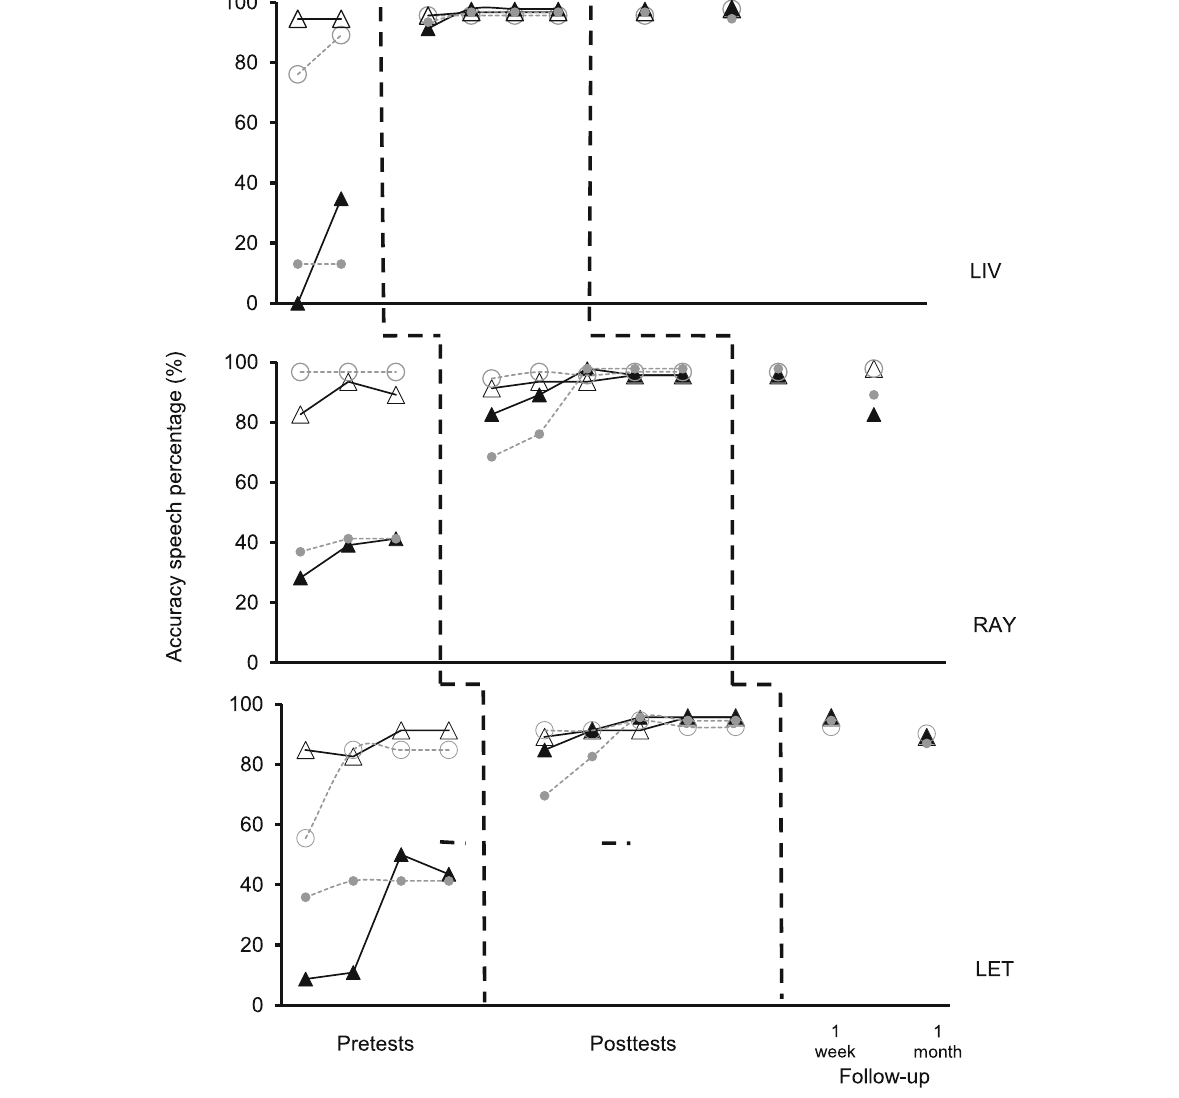
Fig. 3 Accuracy speech percentage in reading (CD) and tacting pictures of scenes (BD) probes. The sentences directly taught (black triangles with solid line) refers diagonal of matrix and recombined sentences (gray circles with dashed line) to others sentences in the matrix. The open